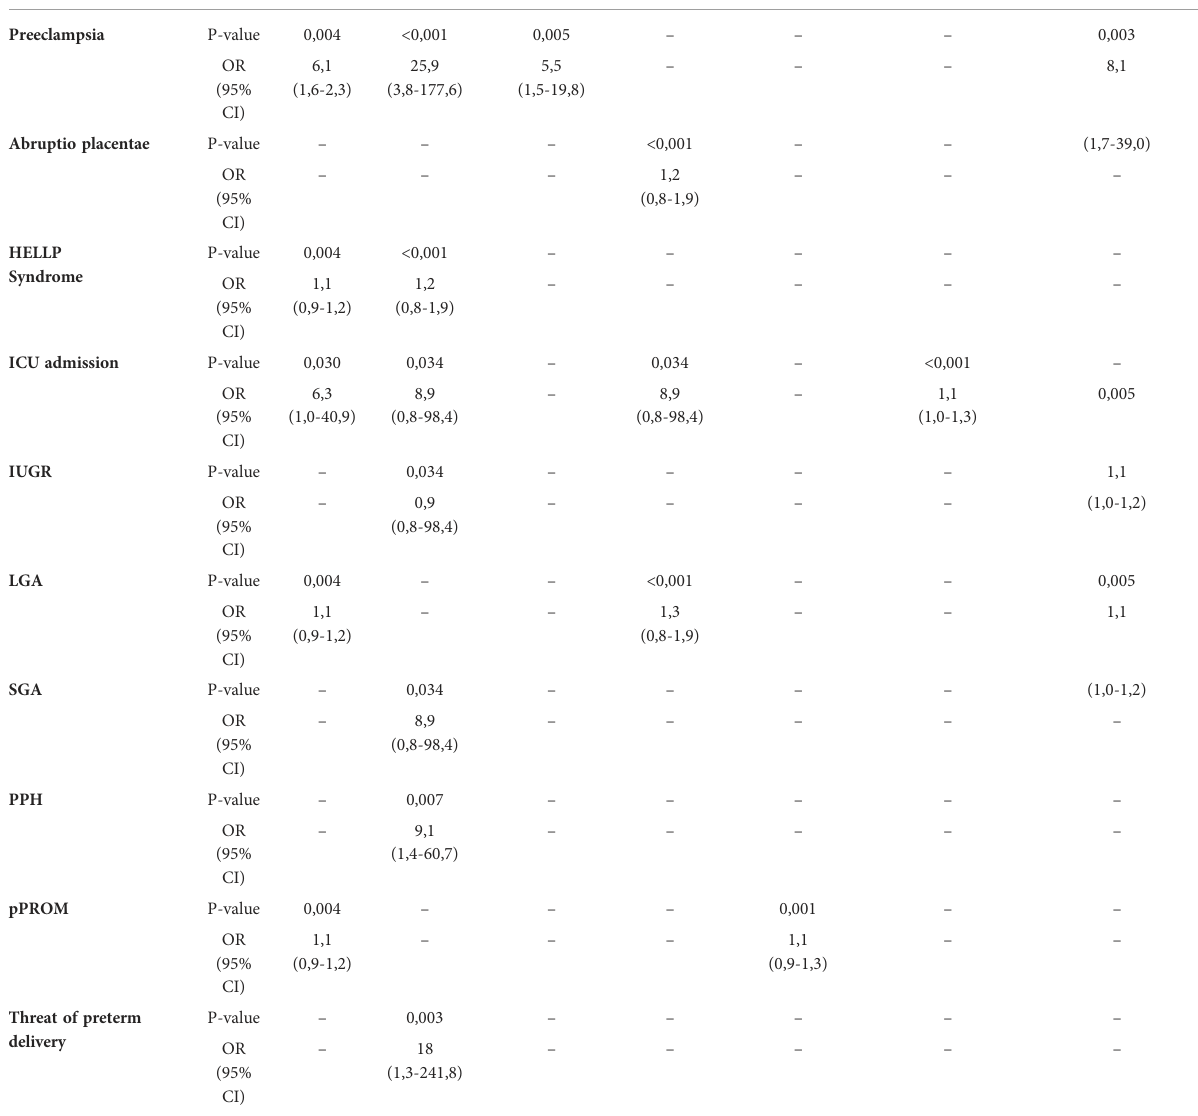
TABLE 3 Univariate logistic regression of statistically signi fi cant parameters and variables involved in pregnancy